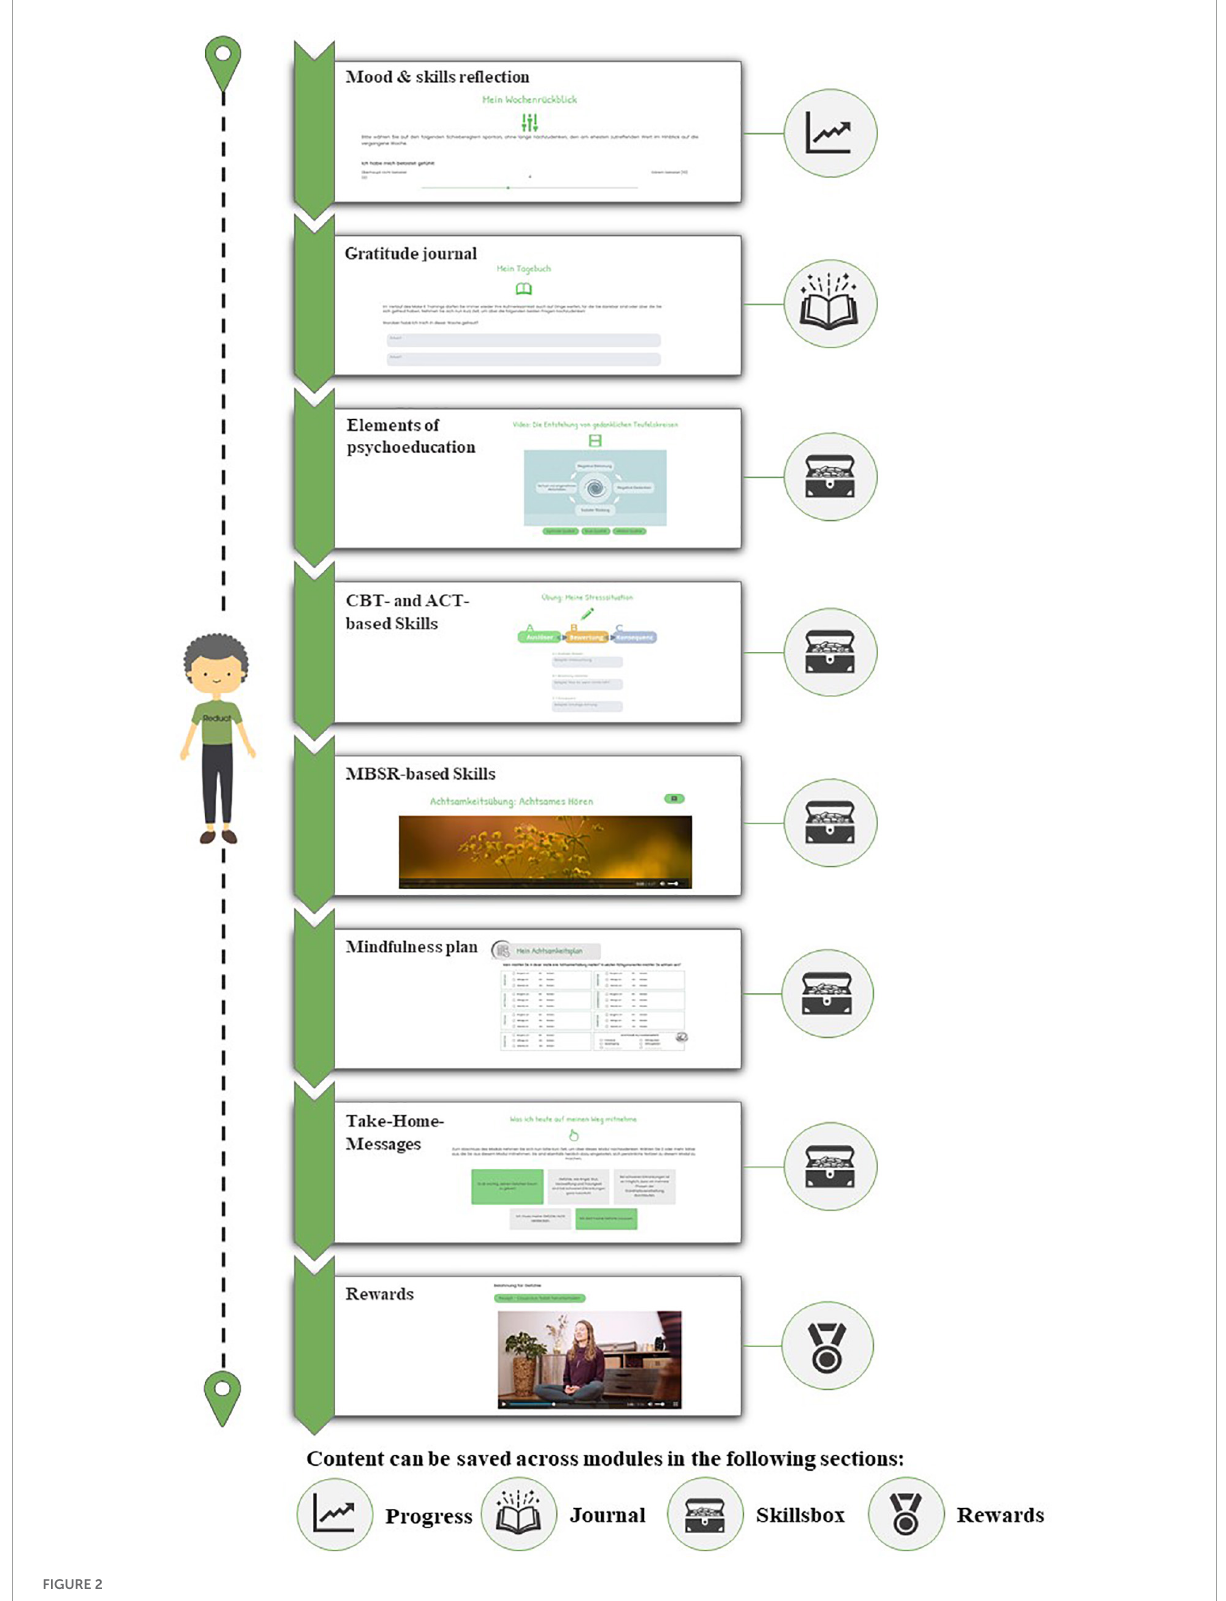
FIGURE2 Structure of the Make It